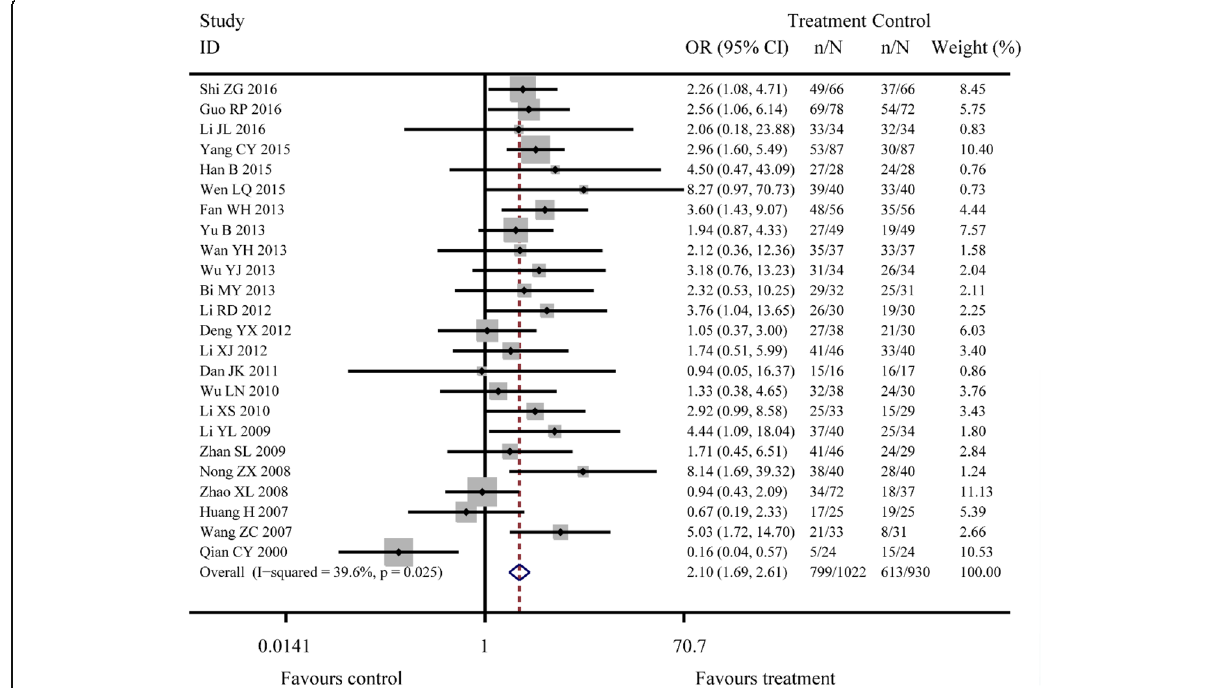
Fig. 3 Meta-analysis of Hp eradication rates about two groups